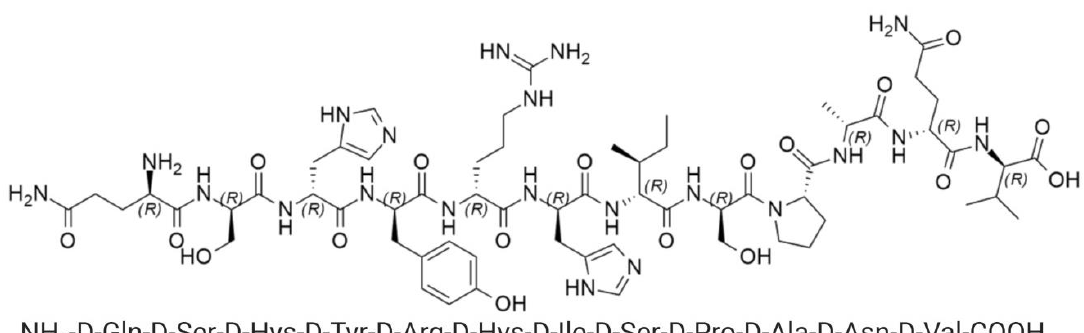
Figure 2. Structure of D1 peptide.